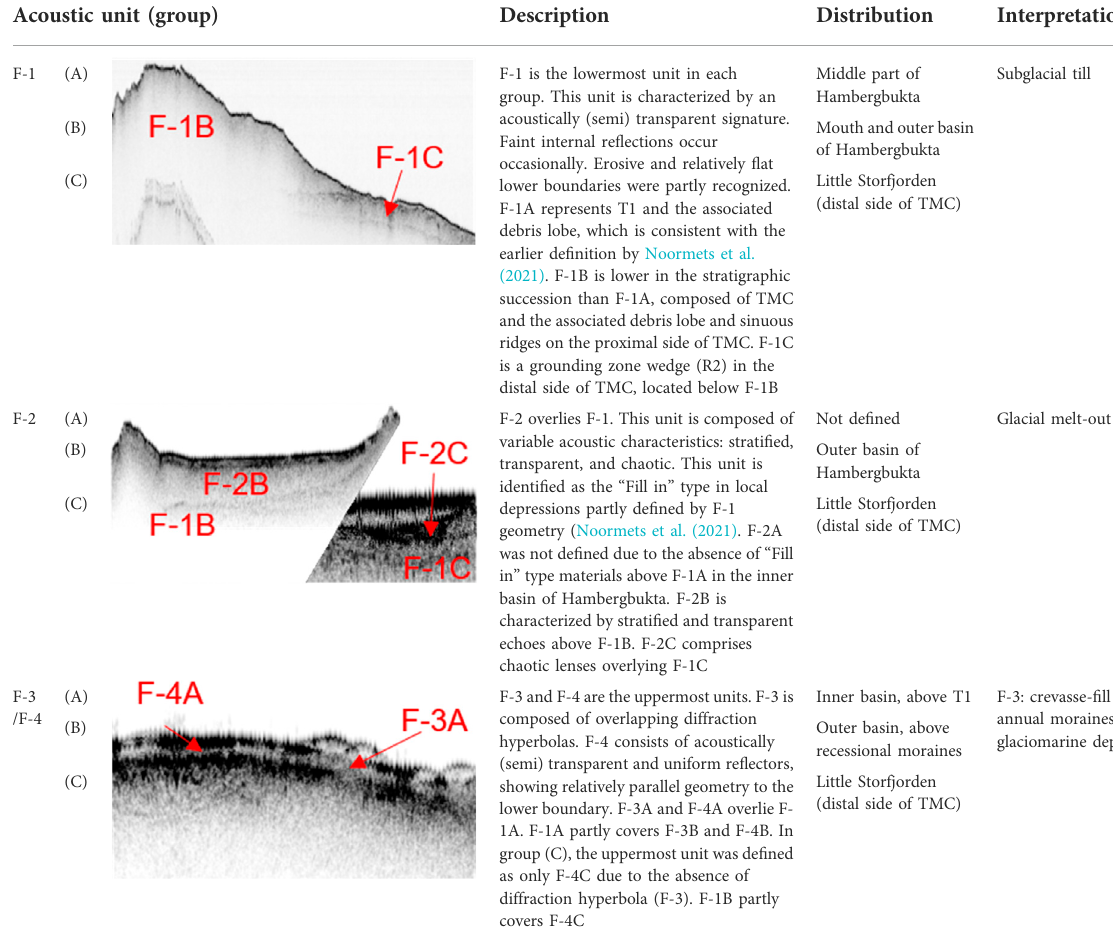
TABLE 2 Acoustic units categorized into three groups (A – C). See Figures 4, 5 for the regional distribution of the